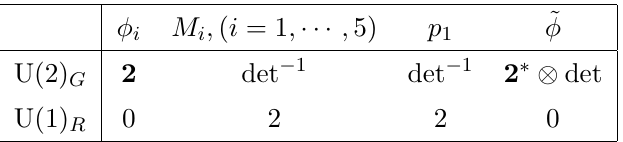
Table 8 . Field contents of dual U(2) GLSM for X 4 ; 6